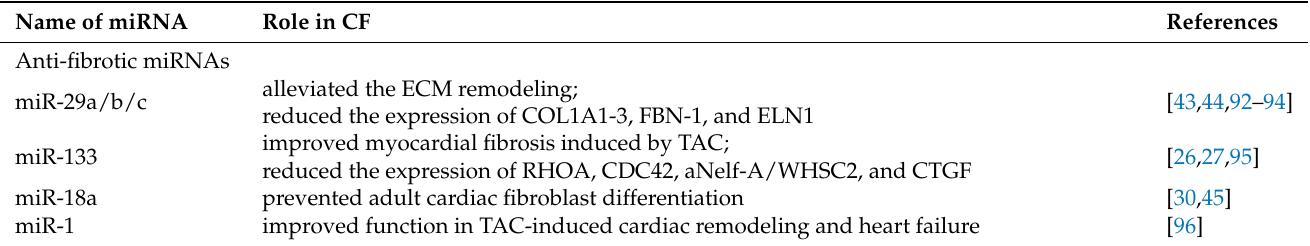
Table 2. Potential therapeutic targets of miRNAs in cardiac